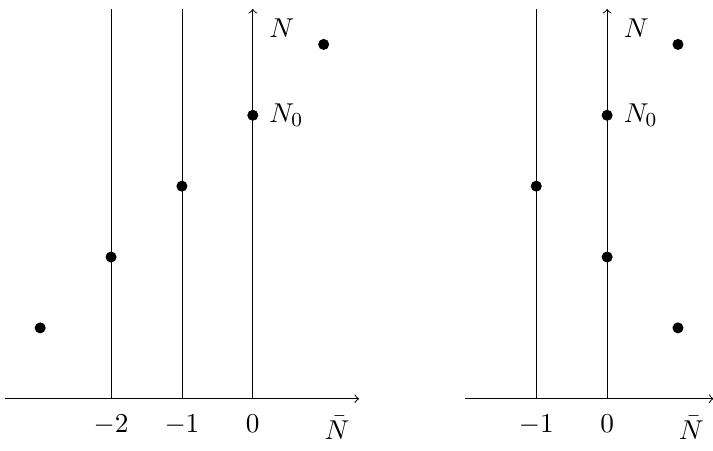
Figure 4 . Weight spaces for cases 1.1.3.1 (on the left) and 1.1.3.2 (on the right). All non-vanishing F and G are equal to − 1 /R 2